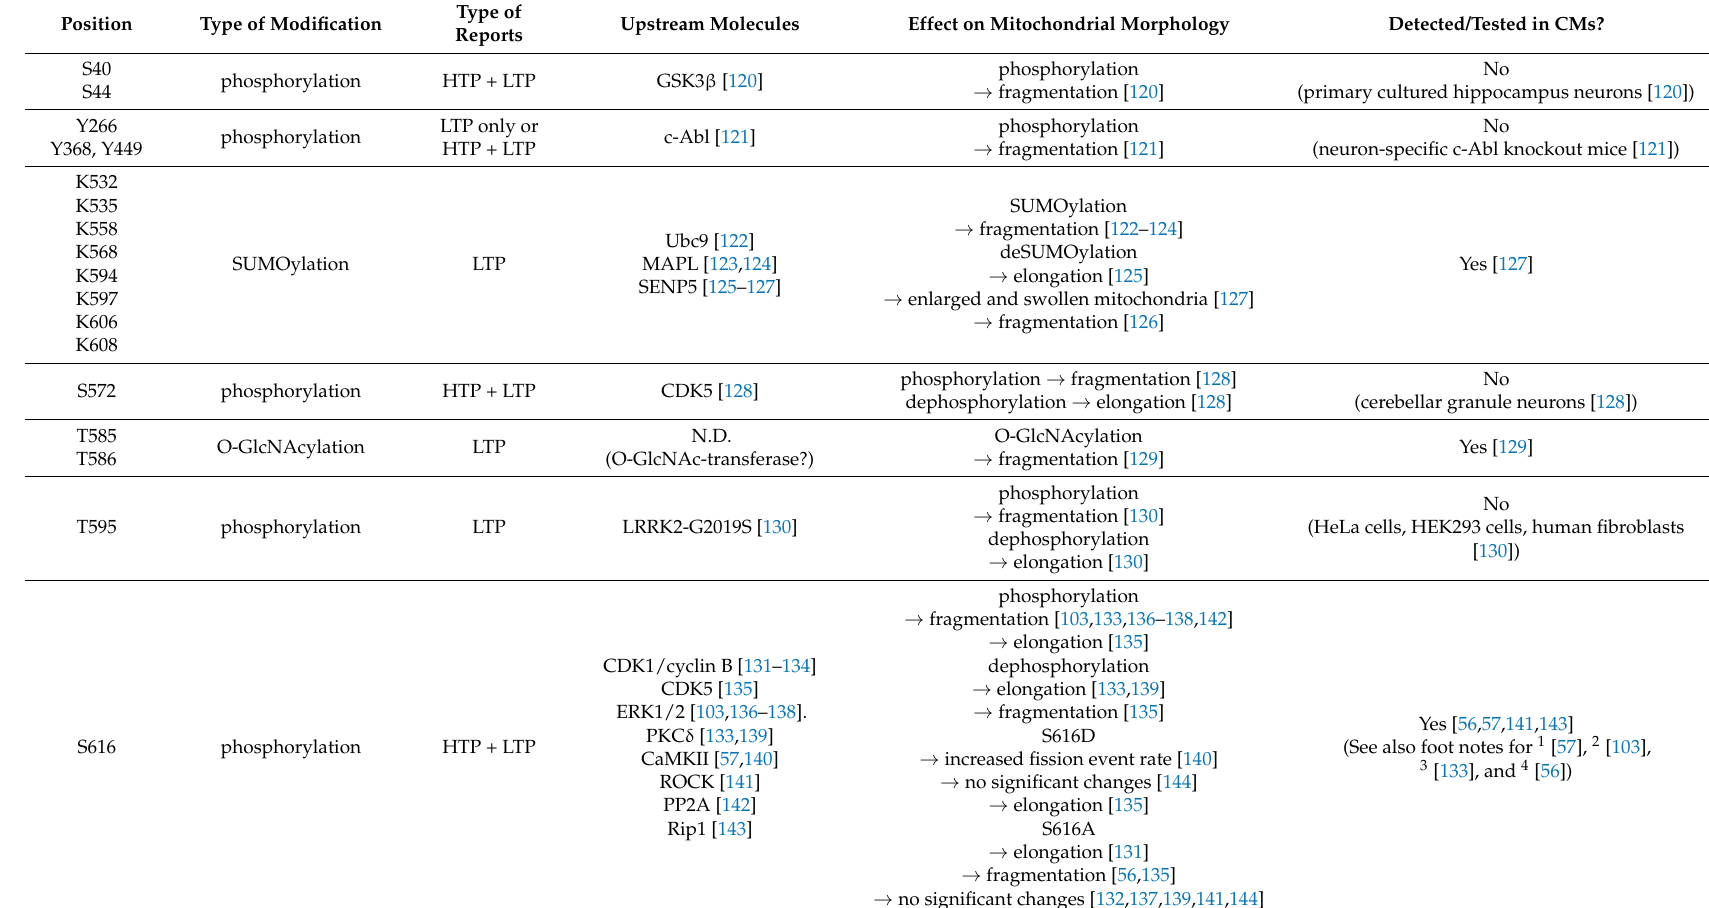
Table 1. Post-translational modifications of DLP1 and their effects on mitochondrial